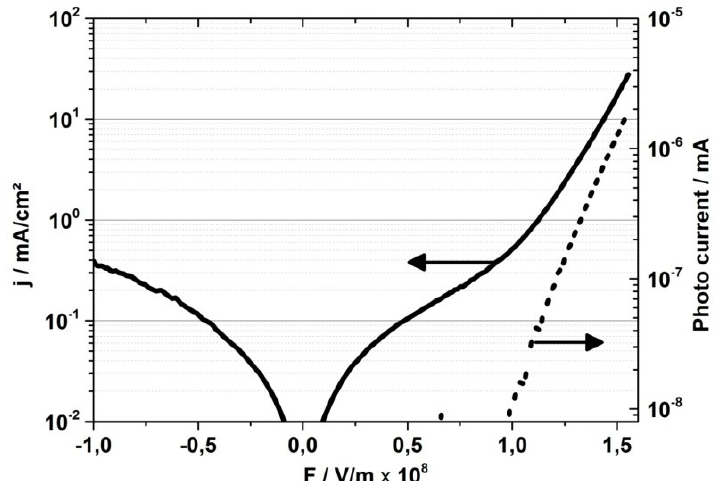
Figure 3. Electrical characteristics of a 1 mm long OLED processed on a defect-free glass stick (diameter 1